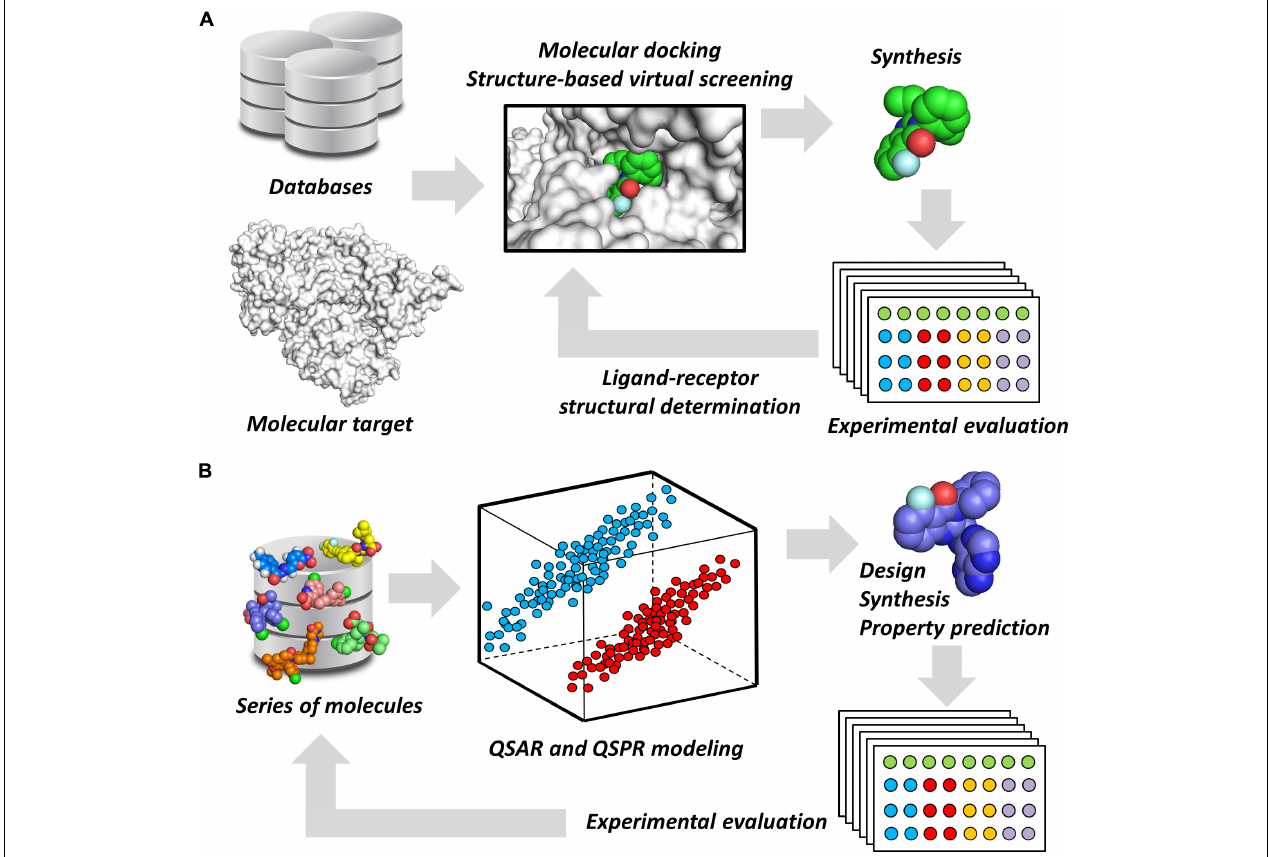
FIGURE 1 | Chemoinformatics strategies. (A) SBDD approaches using virtual screening and molecular docking. These methods are useful for revealing phenomena associated with intermolecular interactions and for improving parameters, such as ligand-receptor affinity. Active molecules can have their binding mode experimentally determined by techniques such as X-ray crystallography. (B) LBDD and the development of QSARs and QSPRs. These are broadly used for the design of novel compounds and for the prediction of pharmacodynamics and pharmacokinetics properties. The experimental data gathered from newly designed compounds can be added to the dataset to generate enriched